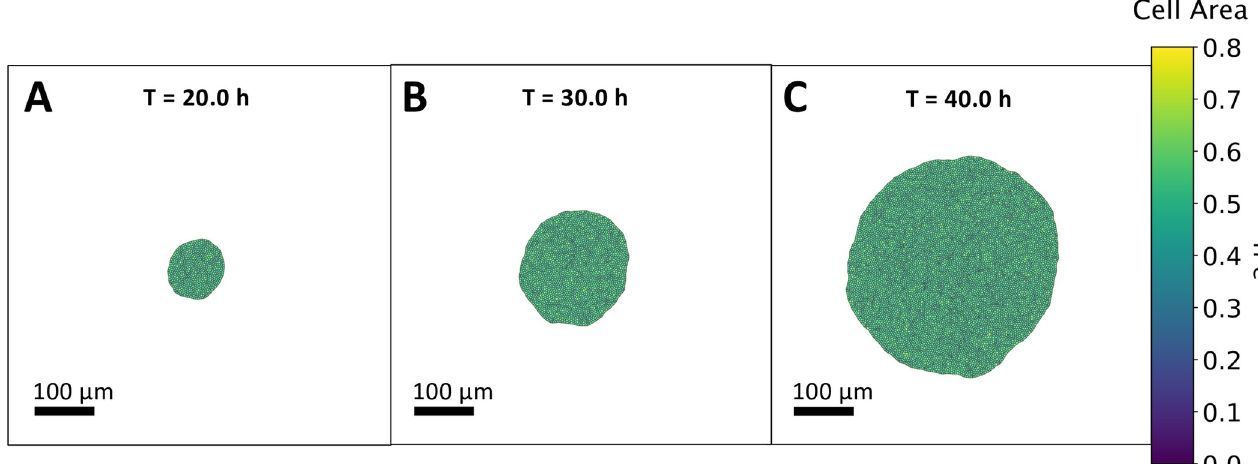
Fig 1. Uniform growth model. A-C: Successive frames of the tissue growth process at different time points, T = 20.0 h , 30.0 h and 40.0 h respectively. The tissue starts at a small size composed of 50 cells and is simulated until it reaches 350 times its original size, allowing the analysis of different growth regimes. Cell division takes place at a constant doubling rate of ~6 hrs. The cells are color coded with respect to their area. The tissue retains a smooth boundary during growth and an approximately circular shape. In early times, the tissue grows continuously and exhibits discontinuities, or avalanches, at later times of ~40 hrs.